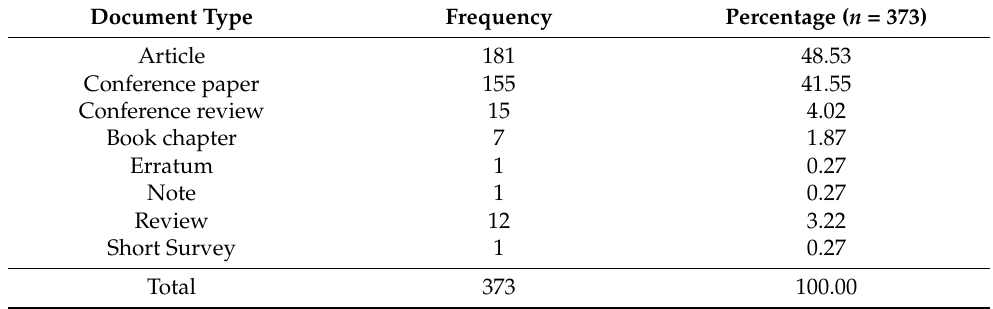
Table 2. Document type from